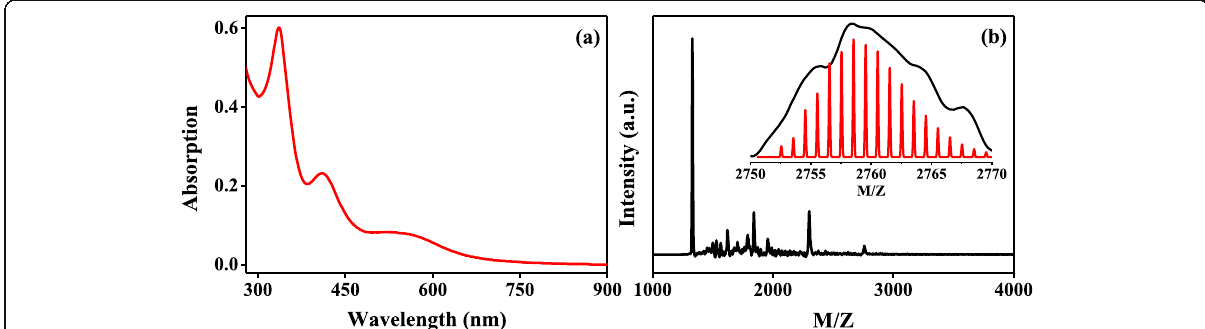
Fig. 1 a UV-Vis absorption spectrum and b MALDI-TOF MS spectrum of the synthesized Ni 6 (SC 12 H 25 ) 12 . The black curve and red curve in Fig. 1b inset represents experimental and simulated results,